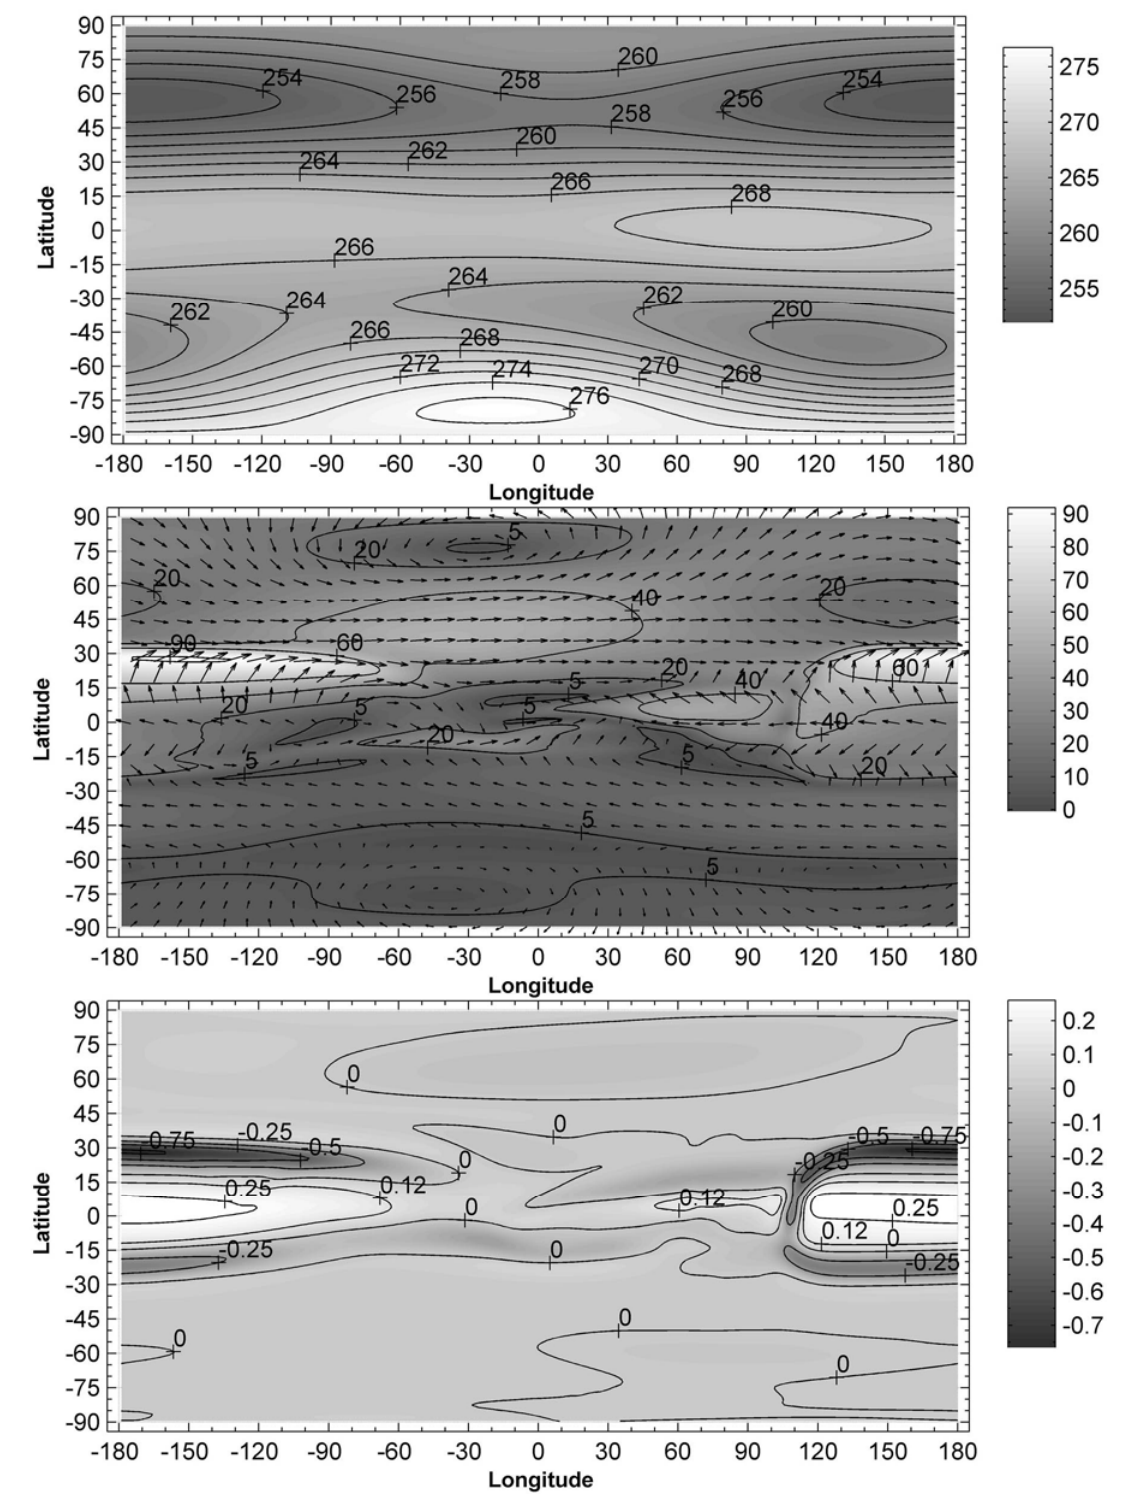
Figure 4. The same as in Figure 1 but obtained for 16